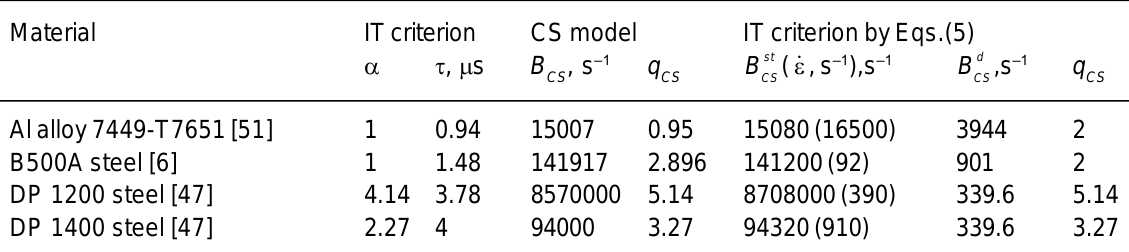
Table 1. Definition of parameters of CS model by IT criterion and comparison these parameters with original values.